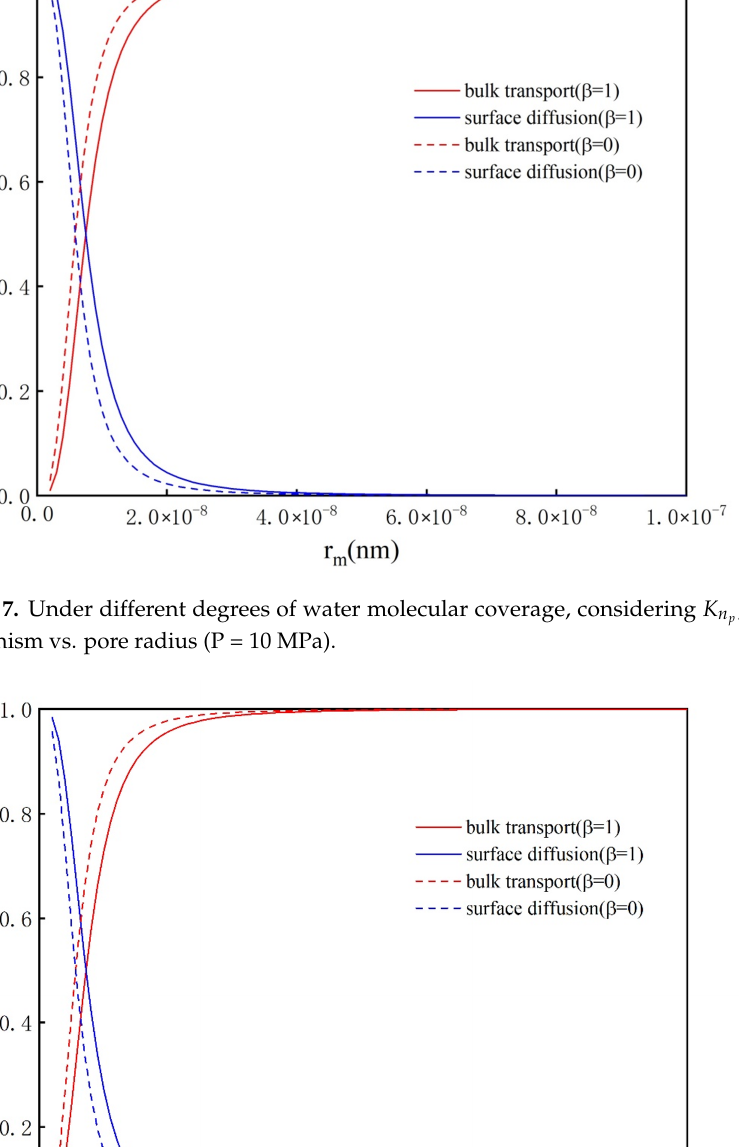
Figure 8. Under different degrees of water molecular coverage, considering K n , the ratio of flow mechanism vs. pore radius (P = 10